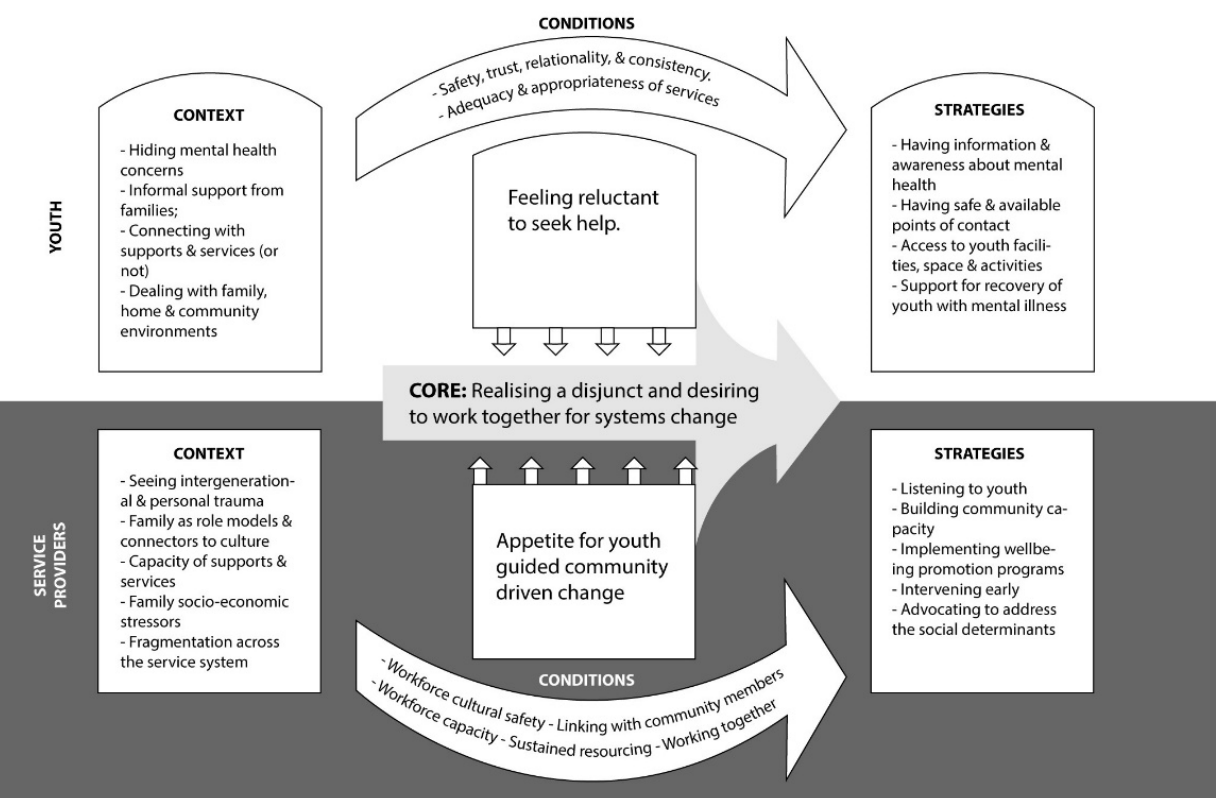
Figure 2. Youth and service providers’ perspectives of Yarrabah youth wellbeing support and ser-